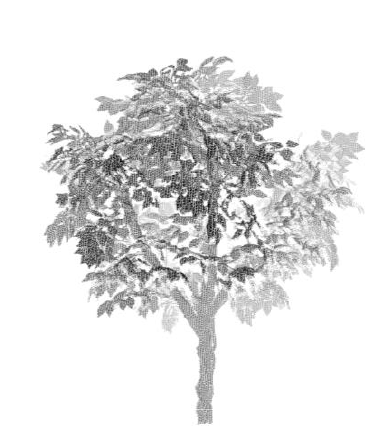
Figure 6. Point cloud of the artificial tree The results of the branch points separation and stem points separation were shown in Figure 7(a) and 7(b)